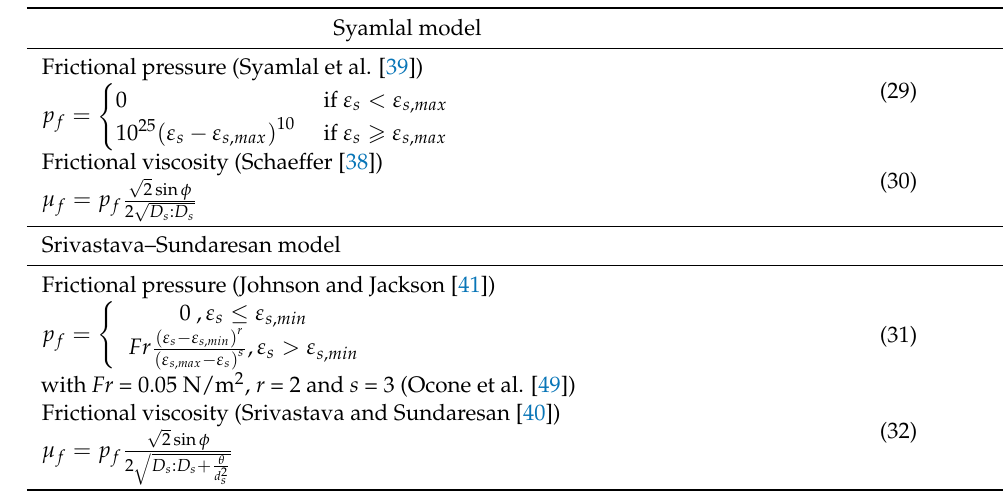
Table 8. Frictional stress models.